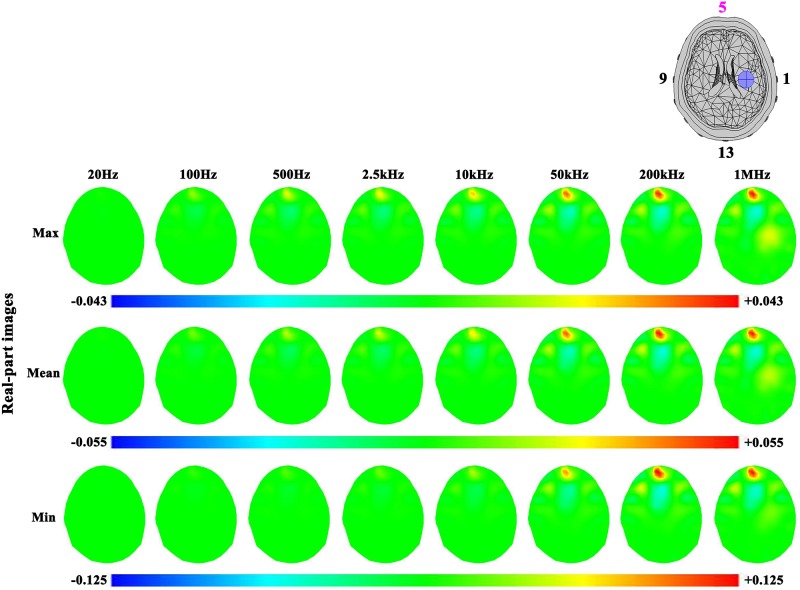
Real-part images of the hemorrhagic stroke lesion and the effects of three levels of contact impedance.